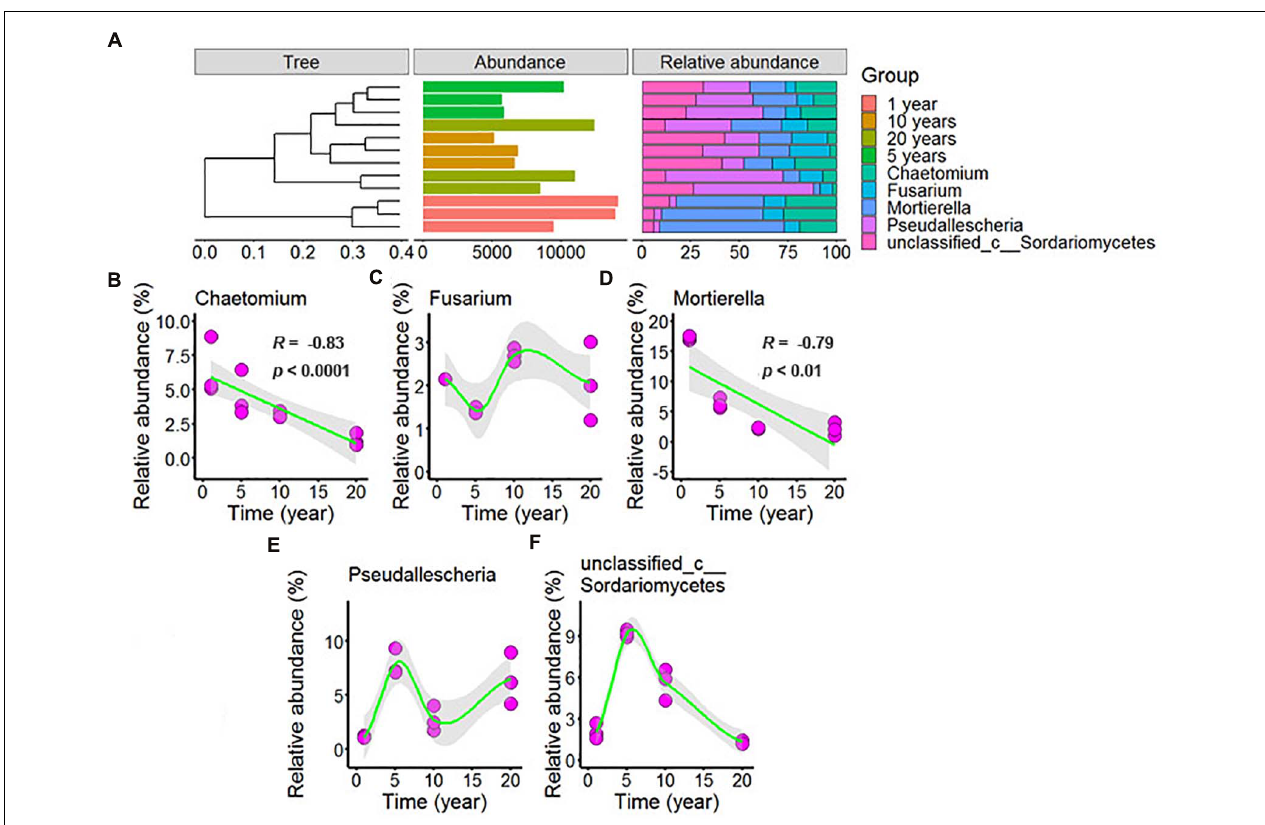
FIGURE 6 | Effect of long-term chili monoculture on the dominant fungi in rhizosphere soil. The “Abundance” in panel (A) was the total abundance of OTUs. Long-term chili monoculture altered the relative abundance of Chaetomium (B) , Fusarium (C) , Mortierella (D) , Pseudallescheria (E) , and unclassified_c__Sordariomycetes (F) . The relative abundances of dominant soil fungi at the genus level of thetaxonomic classification showed different patterns of response to continuous cropping duration (1, 5, 10, and 20 years), including linear and nonlinear relationships. Solid lines represent linear or LOESS fits, and gray areas denote the 95% confidence